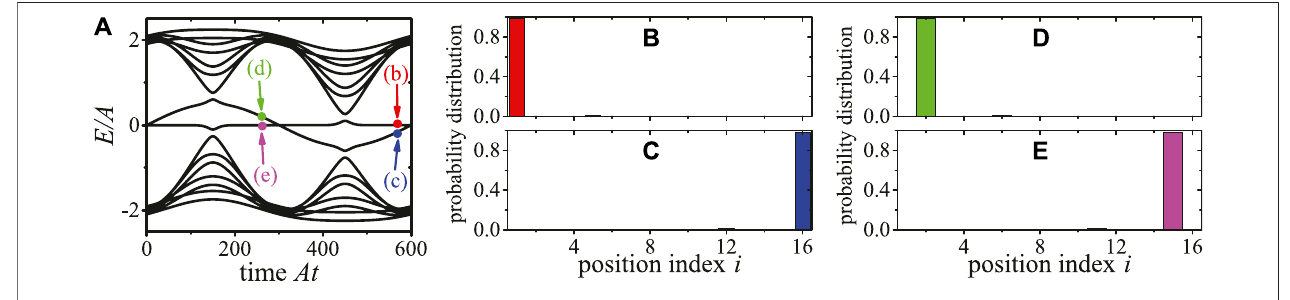
FIGURE10| (Coloronline)Instantaneousspectrum oftheopenchainoptomechanicalarrayfor N (cid:1) 8, J / A (cid:1) 0.1,and ϕ (cid:1) 0.Thetimedependentpumpsequenceis de fi ned in Eq. 30 with ω / A (cid:1) 2 π /600. (B – E) show the probability distributions of the edge states corresponding to the points shown in (A) .